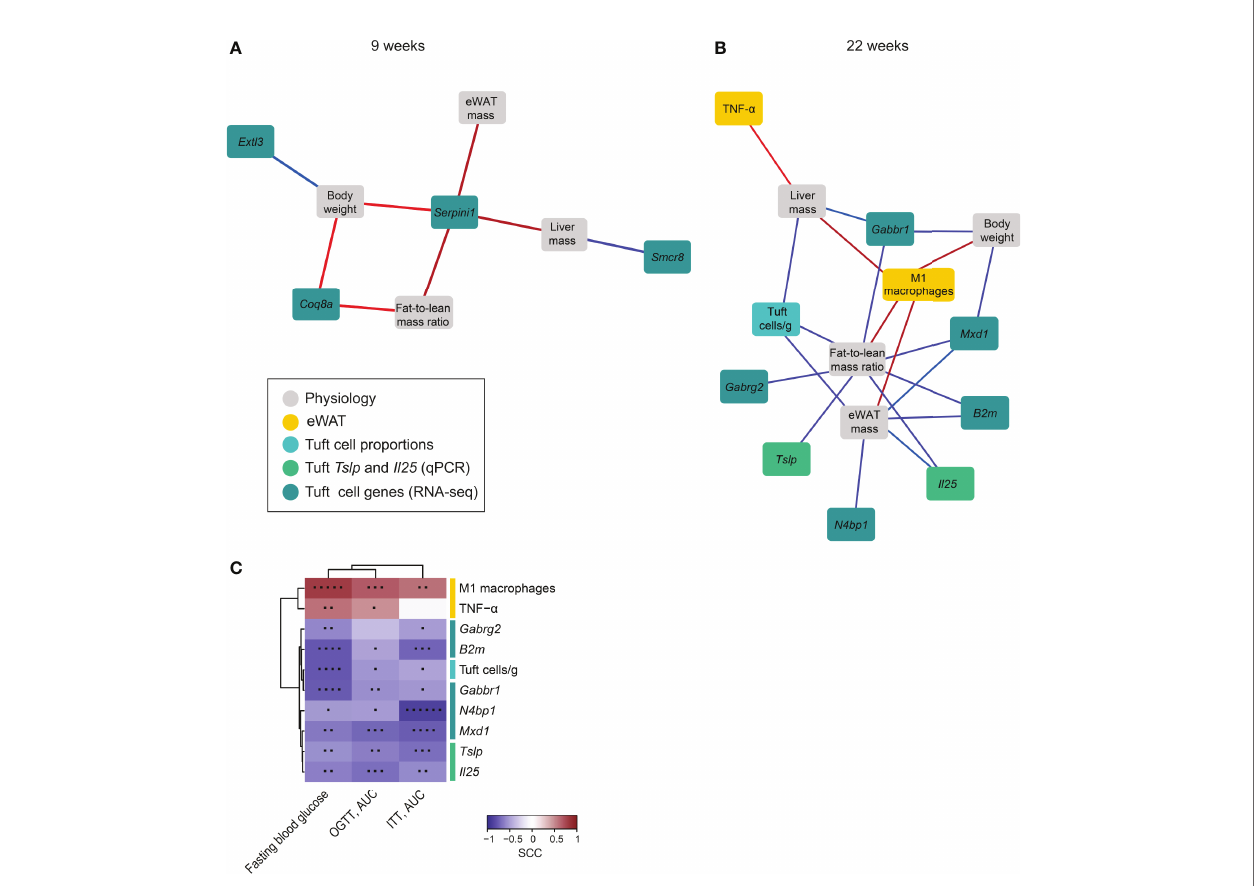
FIGURE 4 | Network analysis interconnects small intestinal tuft cell responses with systemic diet-induced metabolic changes. Network analysis of identi fi ed highly signi fi cant factors from small intestinal tuft cells (numbers and transcripts), key immune cell subsets (ILC2, eosinophils, M2 and M1 macrophages), tissue cytokines and metabolic parameters (total body, eWAT and liver weight and fat-to-lean mass ratio) at 9 (A) and 22 weeks (B) after onset of HFD feeding. The networks display the strongest statistically signi fi cant correlations, 0.7<SCC<-0.7, q- value<0.05, illustrated using Cytoscape. Associations are presented by the color of the lines, where red represents positive and blue negative correlations, and the intensity of the color represents the strength of the correlation. (C) Correlation analysis between the 22 weeks markers and fasting blood glucose (at w20), glucose (at w20) and insulin tolerance levels (at w21) in mice fed HFD for 22 weeks. The heatmap shows spearman rank correlation coef fi cients (SCC; blue: negative, red: positive). Statistically signi fi cant correlations are noted by an asterisk (*p < 0.05; **p < 0.01; ***p < 0.001; ****p < 0.0001; *****p < 0.00001; ******p < 0.000001). N=10-12 mice per group from three repeated